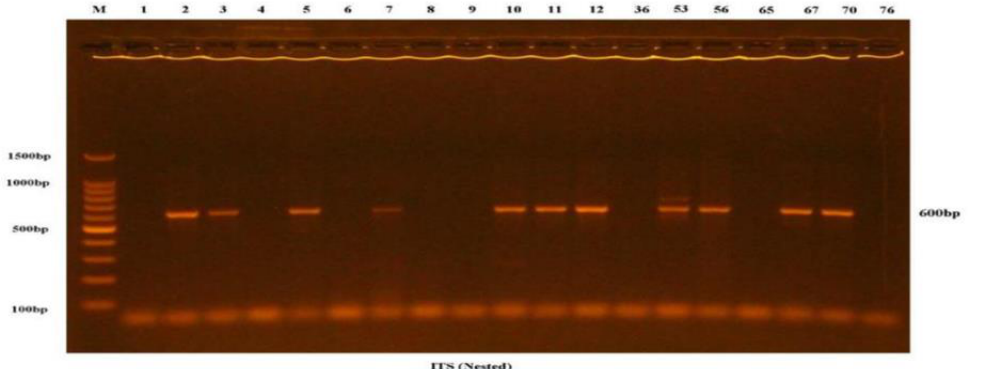
Fig. 4. Amplification of ITS gene of unknown fungal species were fractionated on 1.5% agarose gel electrophoresis stained with Eth.Br. M: 100bp ladder marker. Lanes 1-76 resemble ≈600bp PCR